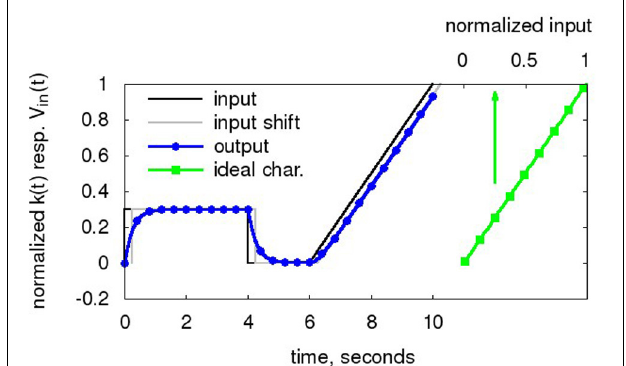
FIGURE 6 | Input waveform V in (t) (black). The Nengo simulator takes this normalizedwaveformasinput.Thedigitizedoutputk(t)(blue,circles),i.e.,the state of the low-pass filter, is also normalized to 0..1. For comparison to the output, V in (t) shifted by τ PSC is also displayed (black, dashed). Also shown is the ideal transfer characteristic (green, dashed, squares) as computed from the decoder weights and tuning curves in Equation 3. Baseline taken from Table 1 , with τ PSC of 256ms for enhanced delay